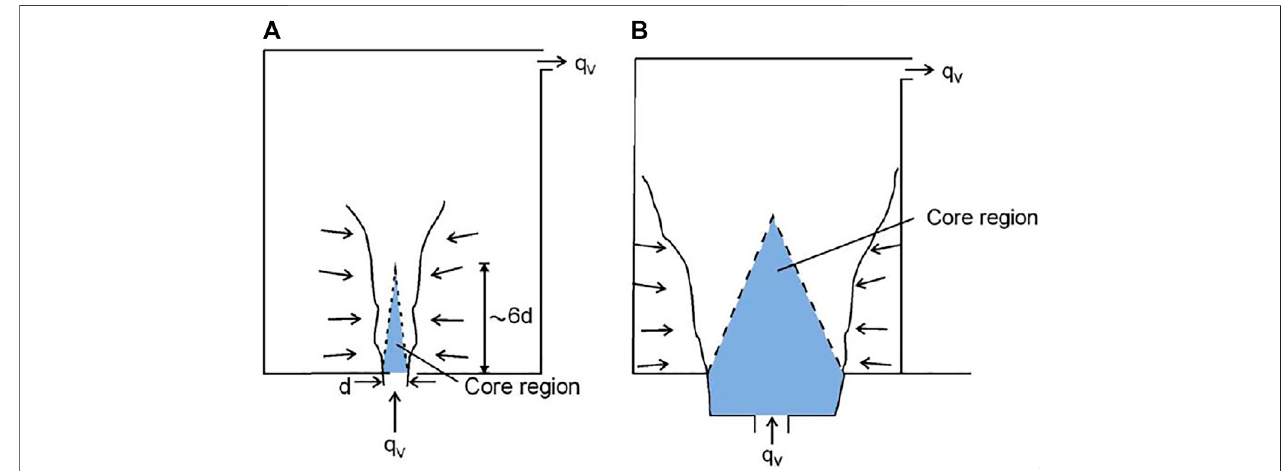
FIGURE 10 | Supply of ventilation air with one jet. (A) Supply with a high velocity. (B) Supply with a low velocity.